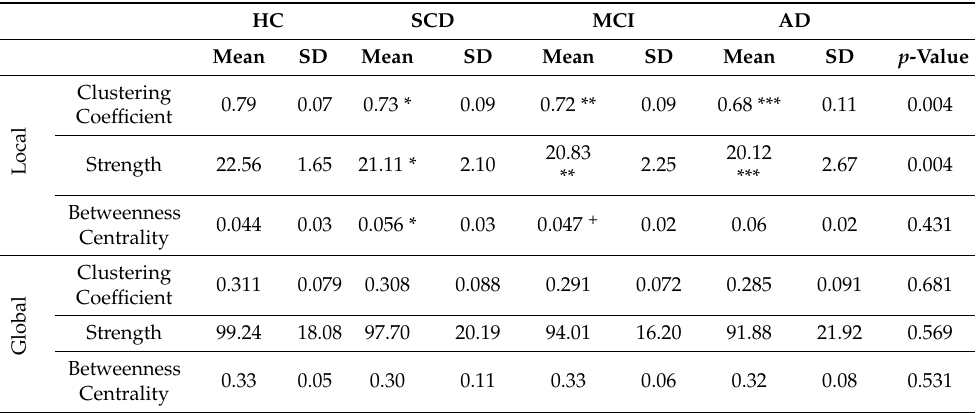
Table 3. Mean ± SD of network properties at a local level (parietal electrodes) and global level (all 256 electrodes) of the participants (HC = 22, SCD = 20, MCI = 30, AD = 20). The last column of the table shows the p -values of one-way ANOVA. Superscripts indicate the statistical significance between groups after independent sample t -tests.